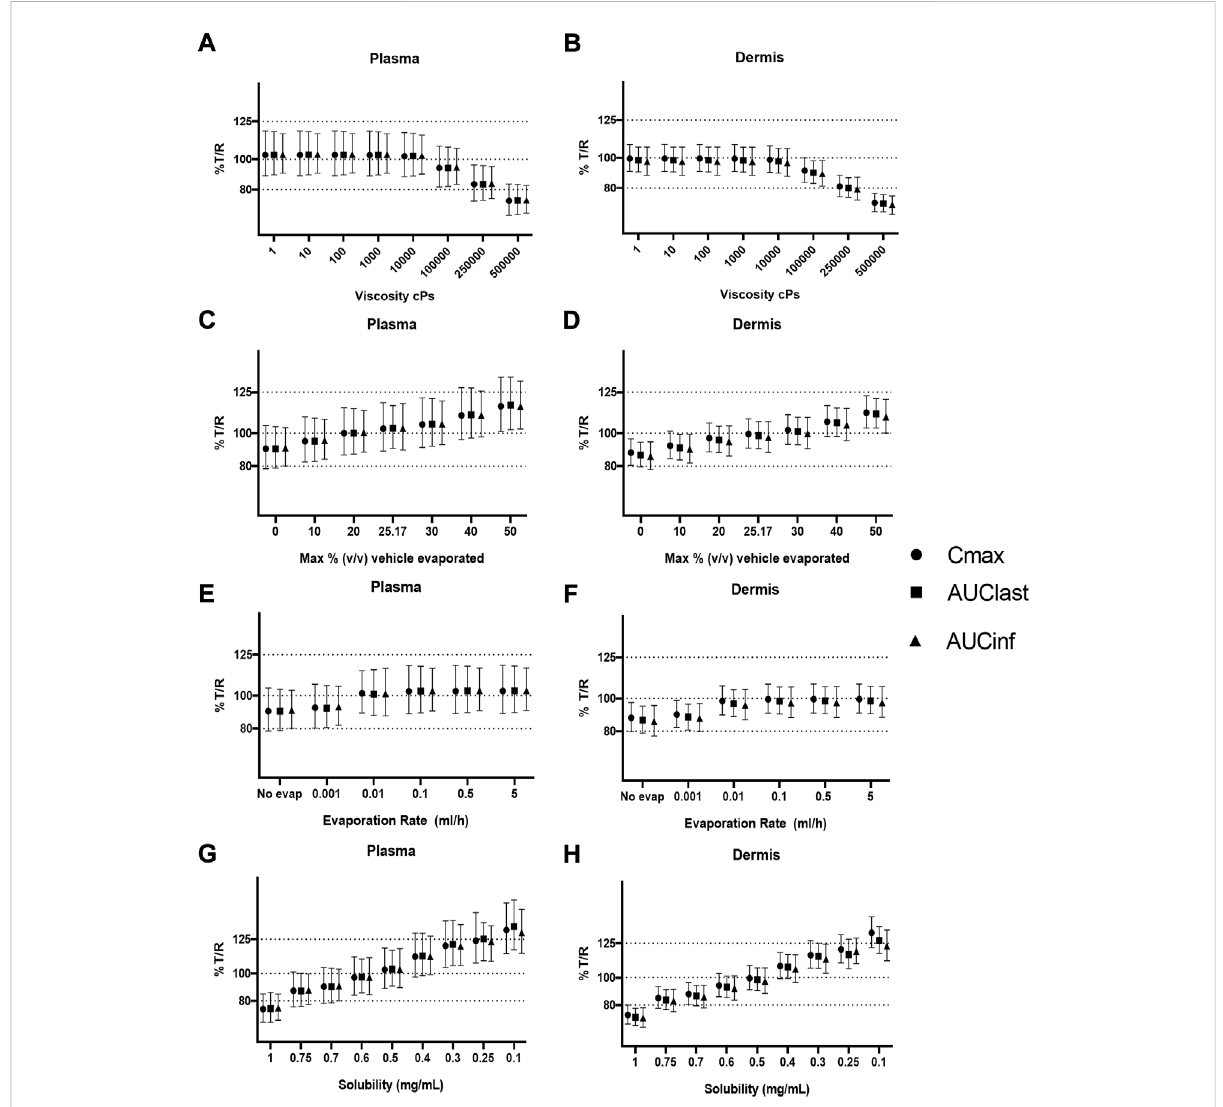
FIGURE 5 Sensitivity analysis of formulation parameters for virtual bioequivalence; viscosity (A,B) , % v/v volatile fraction (C,D) , evaporation rate (E,F) , and solubility of drug in the continuous phase (G,H) for C max , AUC last , and AUC inf in the plasma and dermis.